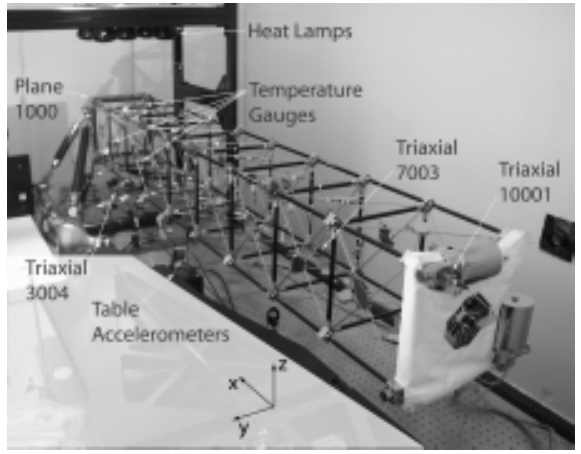
Fig. 1. IPEX-2 Test